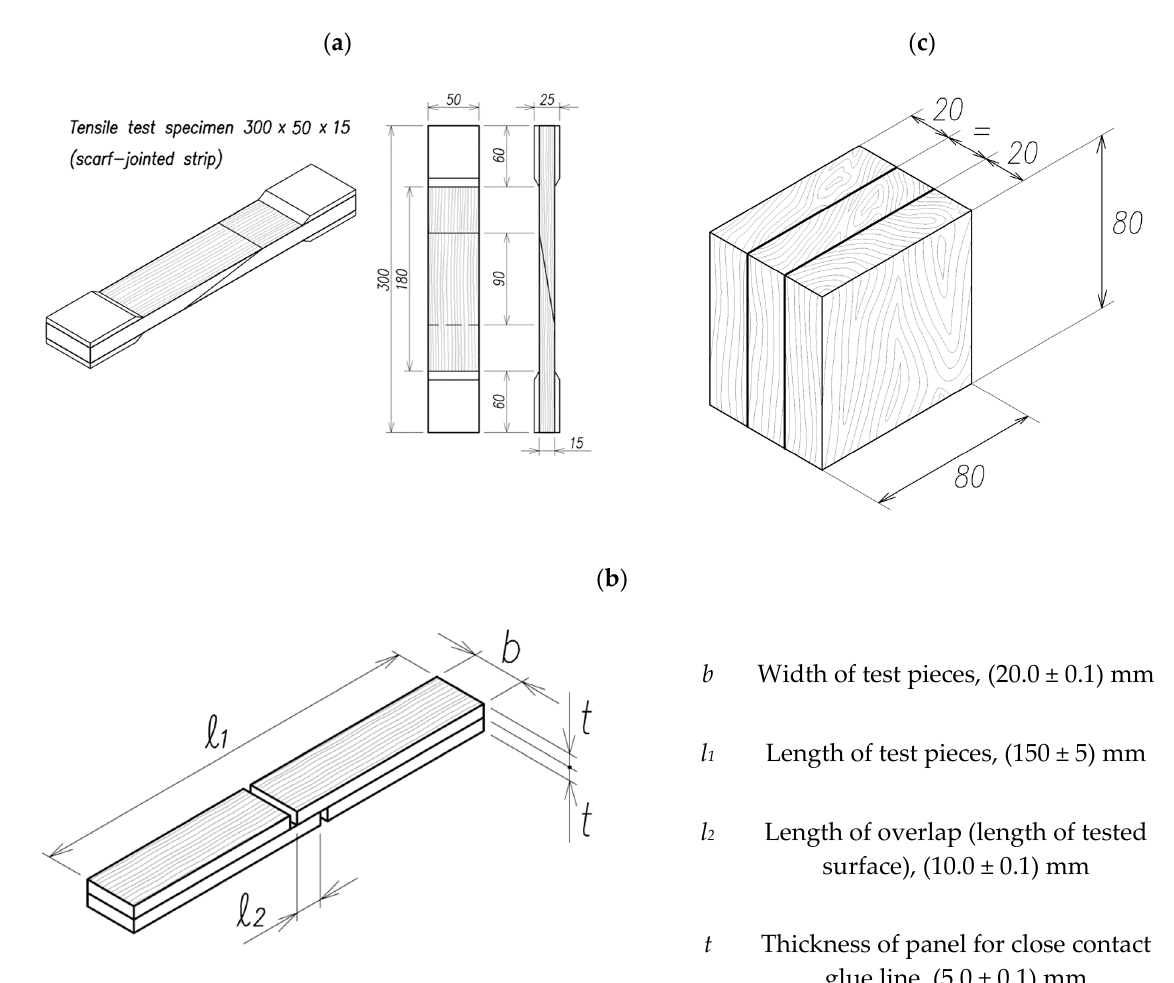
Figure 3. Geometry and dimensions of the tested specimens (units in mm). ( a ) Scarf-joint specimen. ( b ) Tensile-shear test specimen. ( c ) Compression-shear test specimen. specimen. ( c ) Compression-shear test specimen.